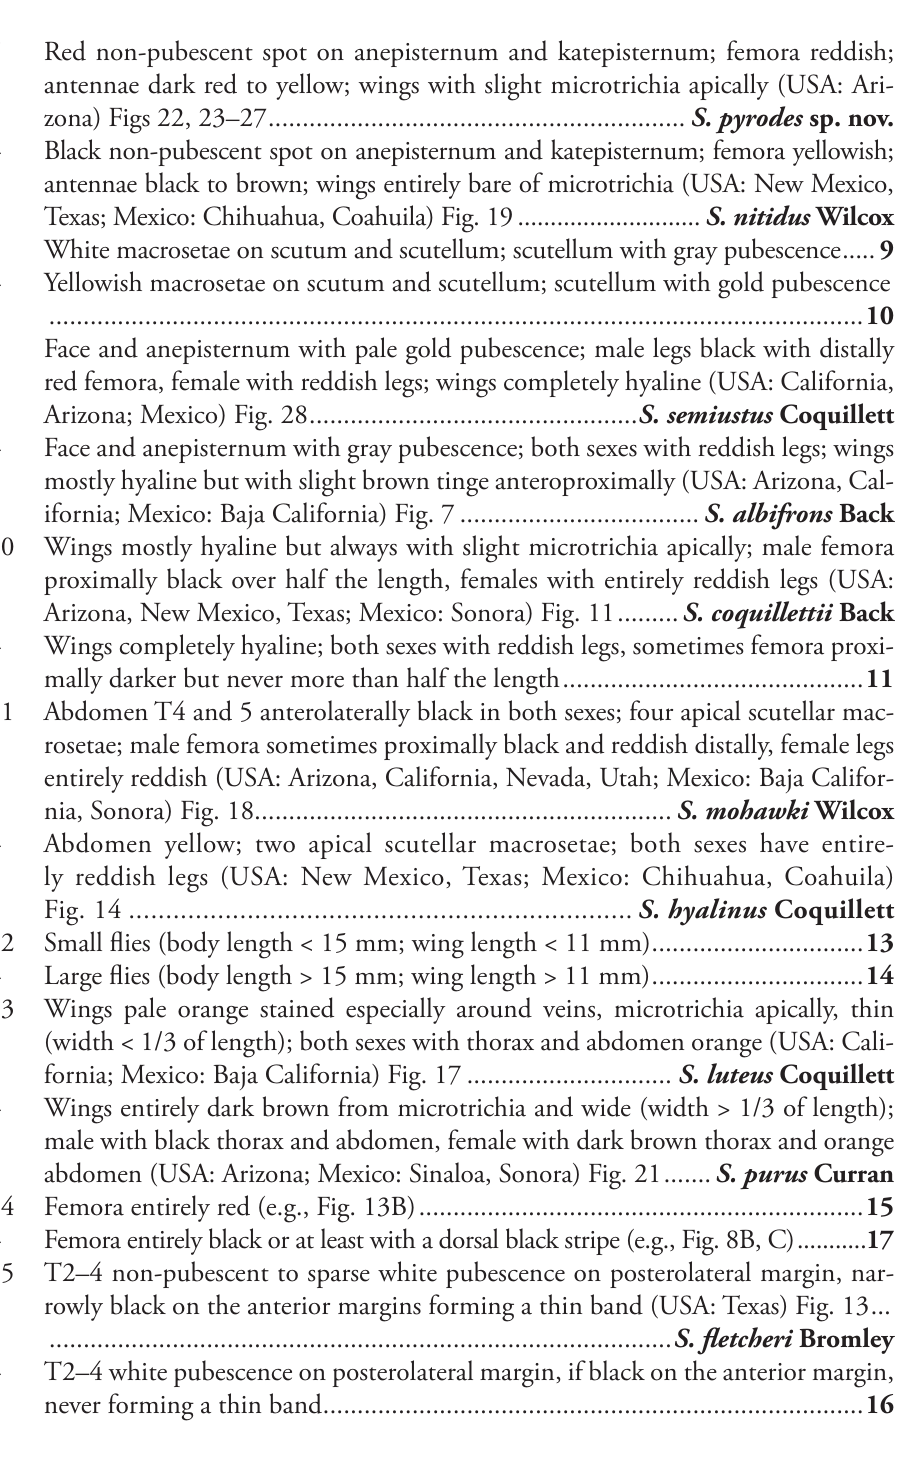
– Femora entirely black or at least with a dorsal black stripe (e.g., Fig. 8B, C) ........... 17 15 T2–4 non-pubescent to sparse white pubescence on posterolateral margin, nar- rowly black on the anterior margins forming a thin band (USA: Texas) Fig. 13 ... – T2–4 white pubescence on posterolateral margin, if black on the anterior